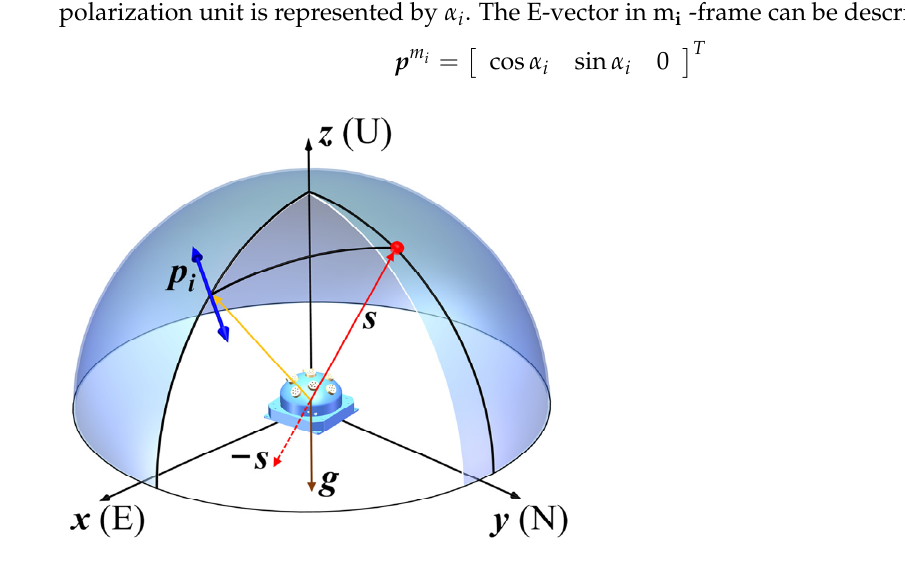
Figure 3. The geometrical description of the main vectors used in the solar vector calculation. Then, the E-vector in b-frame is given by lation matrix of the monocular polarization unit, the calibration of which is detailed in Ref [26]. According to the single-scattering Rayleigh based theory, all E-vectors are orthogonal to the solar vector in CPP. The orthogonal relationship is also valid in b-frame, i.e.,